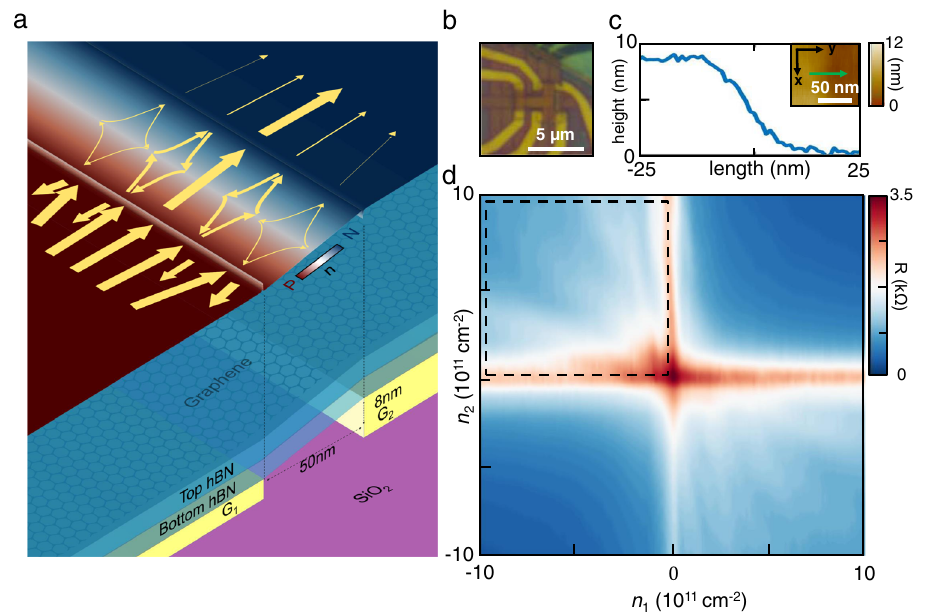
Fig. 1 | Strain-de fi ned and gate-tunable micro-cavity. a (Bottom) hBN- encapsulated monolayer graphene transferred on top of a pair of atomically fl at local bottom gates of different heights. (Top) The color plot maps the carrier density distribution in the device. Two narrow depletion regions form along the boundariesofthegates,wheresmoothlatticedistortionshappen.(Arrows)Ballistic